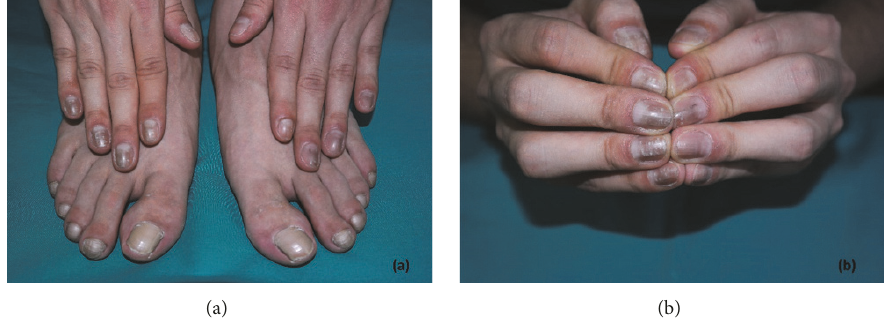
Figure 1: Whole fingernails and toenails of our patient. Normal toenails except for the second ones which have transverse lamellar splitting (a) and grayish pigmented bands with varying widths and intensities on fingernails, predominantly on right hand; loss of cuticle and erythema of proximal nail folds which can also be seen on both hands (b).